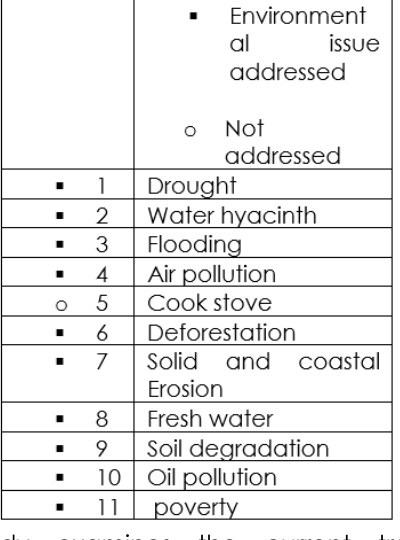
Table 2: Showing Federal Government Perspective of environmental challenges in